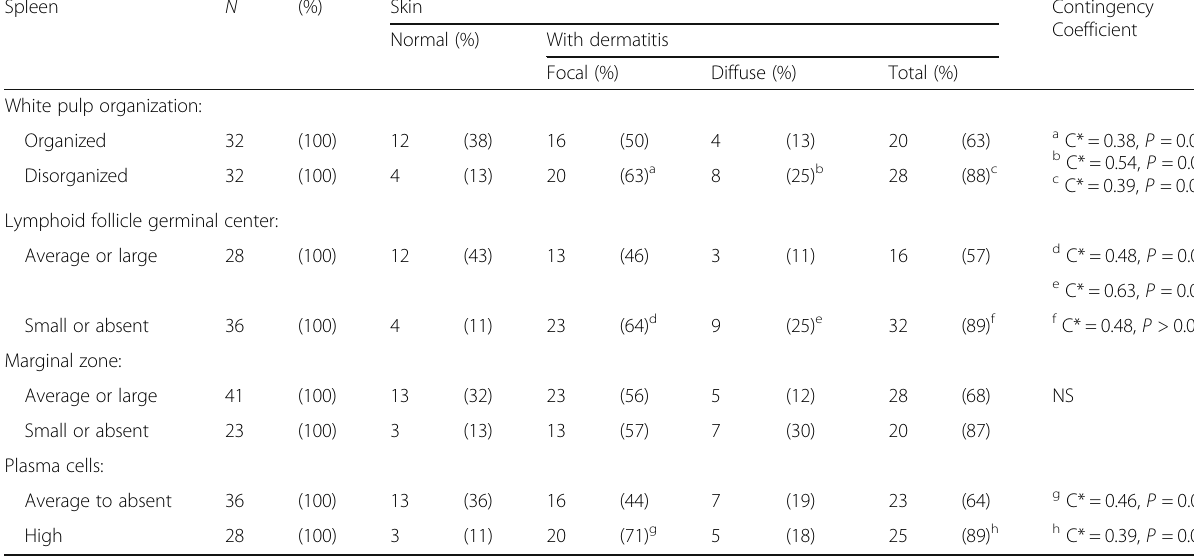
Table 4 Associations between dermatitis and splenic changes in stray dogs from an endemic area of visceral leishmaniasis Spleen N (%)